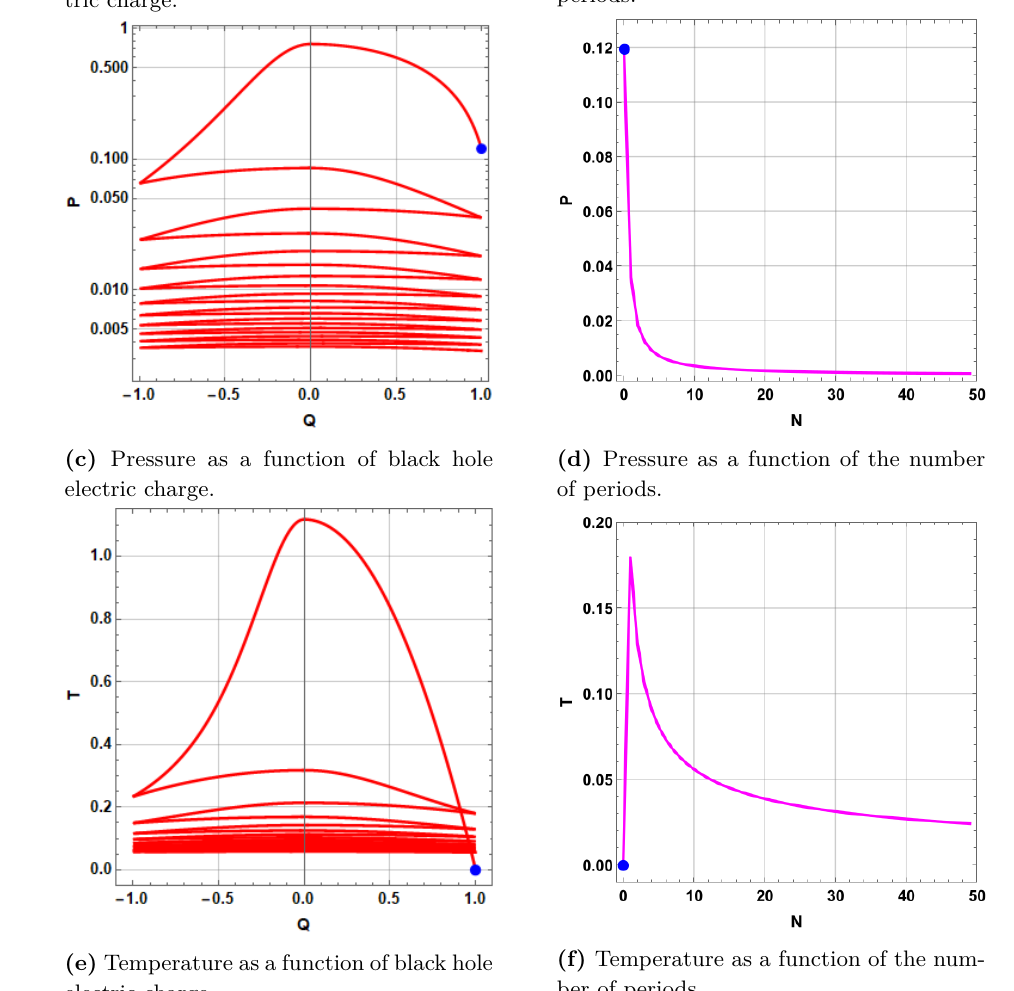
Figure 14. Evolution of different thermodynamical variables during absorption of 10 5 particles over 50 periods. The initial conditions (blue dot) are Q = 1 , l = 1 , M = 1 . 23 , r h = 0 . 65 , and D = 4